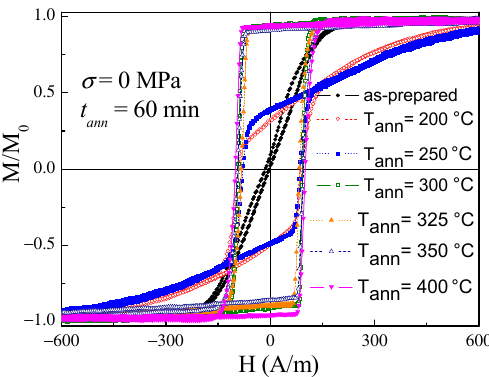
Figure 12. Hysteresis loop of the Fe 3.6 Co 69.2 Ni 1 B 12.5 Si 11 Mo 1.5 C 1.2 microwires annealed without stress at different temperatures. (Reproduced with permission from [49] Copyright © 2020 Elsevier B.V).